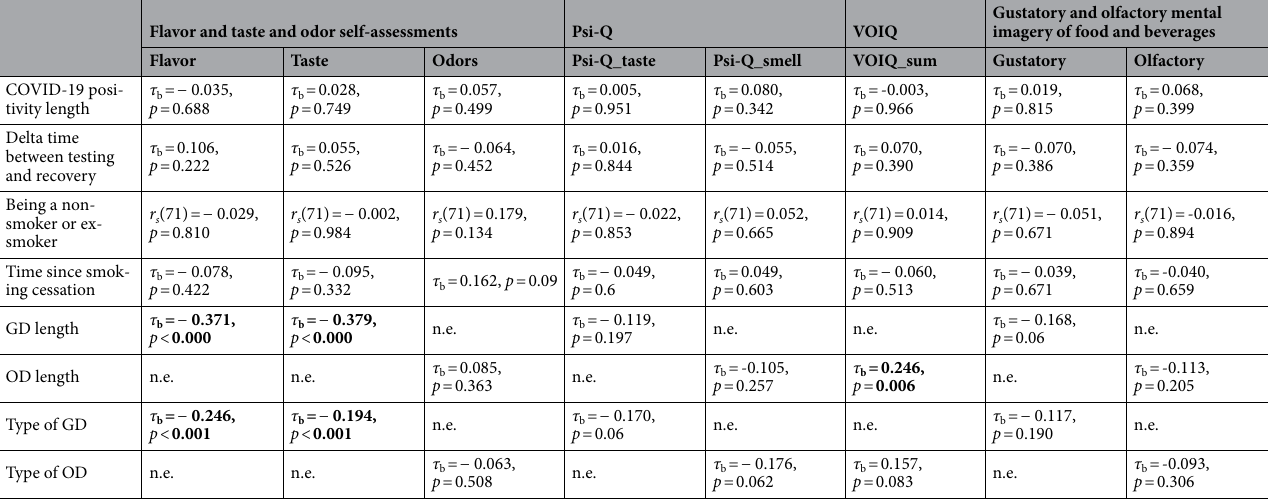
Table 5. Results of the correlation analyses. Significant values are in bold. n.e. = not executed because of no interest in the planned correlation